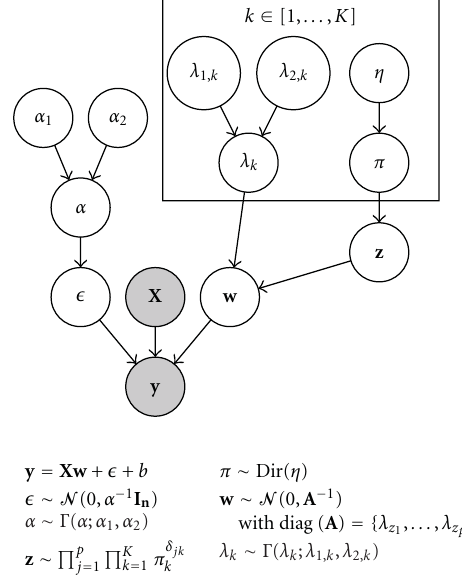
Figure 1: Graphical model of Multiclass Sparse Bayesian Regression (MCBR) . We denote by y ∈ R n the targets to be predicted and by X ∈ R n × p the set of activation images. both the weights of the model w depend on a discrete variable z that assigns each feature to a class k among K . Both the noise (cid:2) and the weights w have a Gamma prior on their precisions. The variable z follows a Dirichlet prior π